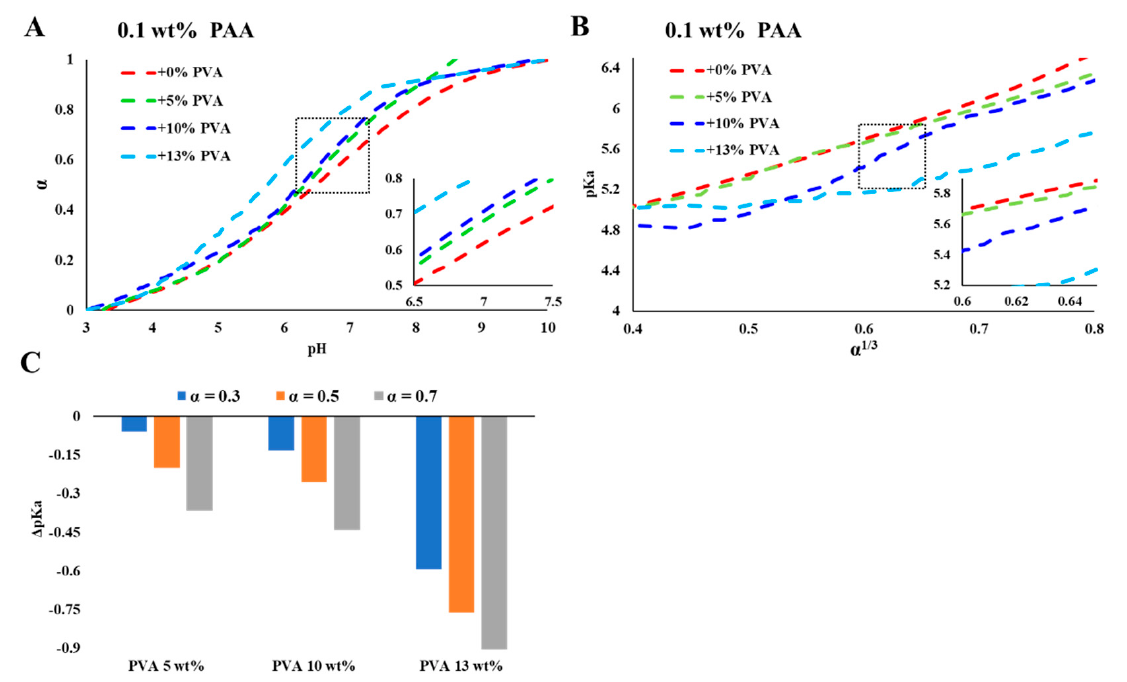
Figure 2. Titration curves of PAA 100 kDa (0.1 wt%) in PVA solutions. ( A ) The degree of ionization ( α ) as a function of pH , ( B ) pK a as a function of α 1/3 , ( C ) ∆ pK a (as compared to additive-free PAA solutions) in PVA solutions of 5, 10, and 13 wt% for α = 0.3, 0.5, and 0.7.